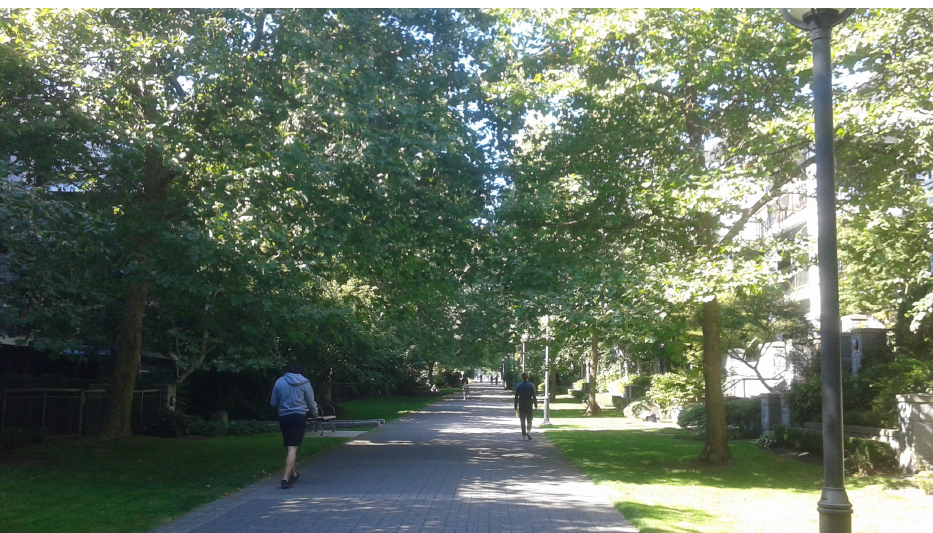
Figure 1. The studied green street in Vancouver, Canada.